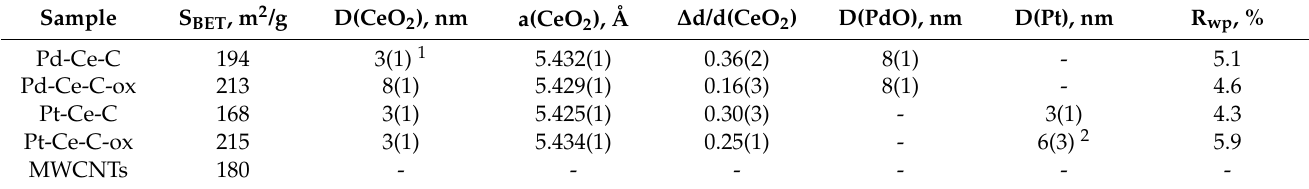
Table 1. The specific surface area (S BET ) of the samples; and the structural parameters of the phases detected in the catalysts by XRD: D- average crystallite size, a(CeO 2 )—cell parameter, ∆ d/d— microstrain parameter, R wp —weighted profile